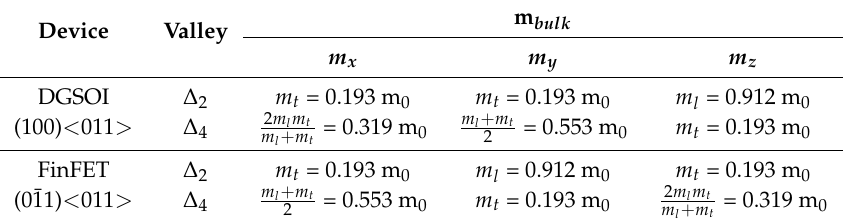
Table 1. Silicon bulk effective masses (m bulk ) for the different crystallographic directions considered in the DGSOI and FinFET devices. Herein, m x and m z are the transport and confinement masses, respectively; m y is the effective mass in the periodic transverse direction; m 0 is the free electron mass; and the subindex of ∆ represents the degeneracy factor associated with the conduction band valley. m bulk Device Valley m x m y m z DGSOI ∆ 2 m t = 0.193 m 0 m t = 0.193 m 0 m l = 0.912 m 0 (100) < 011 > ∆ 4 2 m l m t = 0.553 m 0 m t = 0.193 m 0 = 0.319 m 0 m l + m t m l + m t 2 FinFET ∆ 2 m t = 0.193 m 0 m l = 0.912 m 0 m t = 0.193 m 0 m l + m t (0¯11) < 011 > ∆ = 0.553 m 0 m t = 0.193 m 4 2